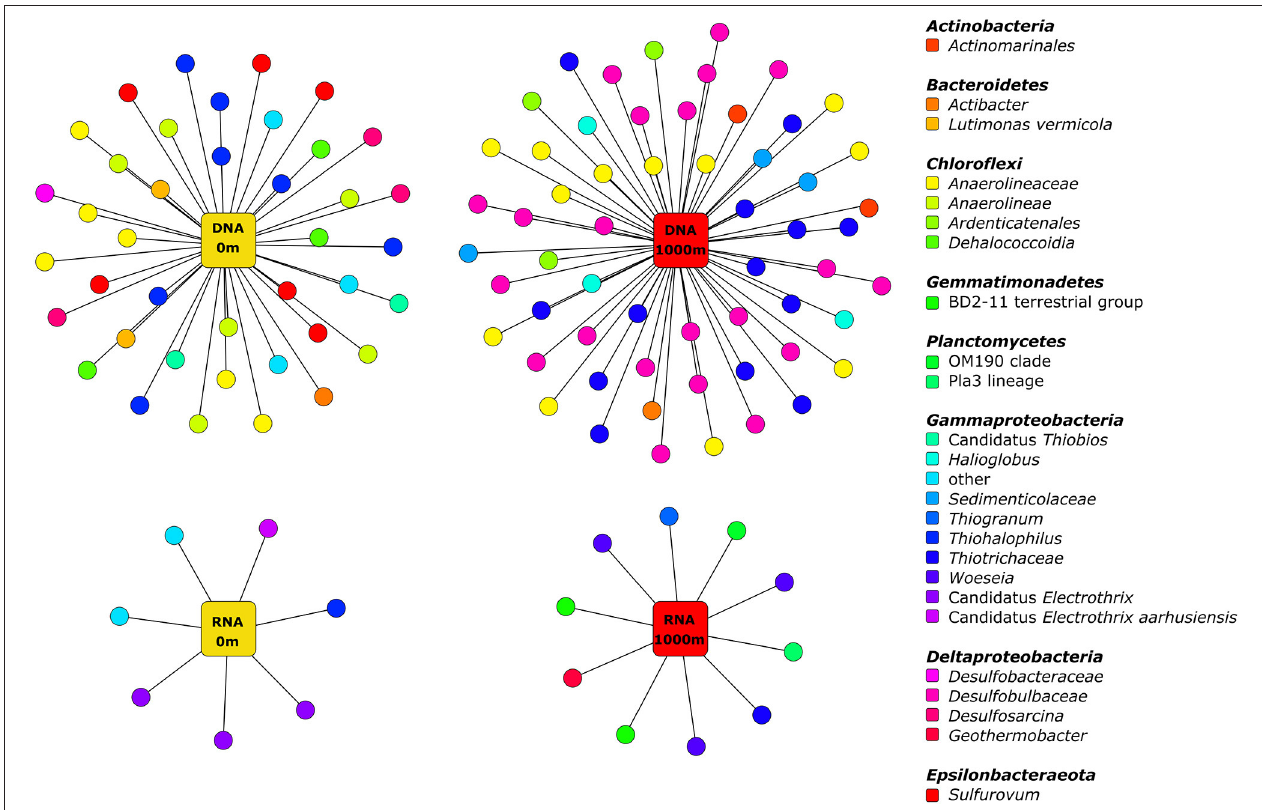
FIGURE 6 | Bipartite association network of significantly associated bacterial taxa close to and far from storm strains in embayment sediments. Only uniquely associated taxa from entire (DNA) and active (RNA) bacterial communities are shown. For further information see Supplementary Table 5